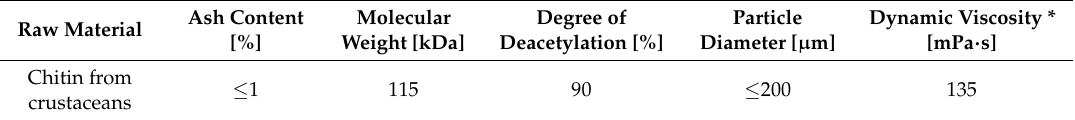
Table 1. Properties of industrially produced chitosan used for the preparation of the coating formulation [32]. Ash Content Molecular Degree of Raw Material [%] Weight [kDa] Deacetylation [%]